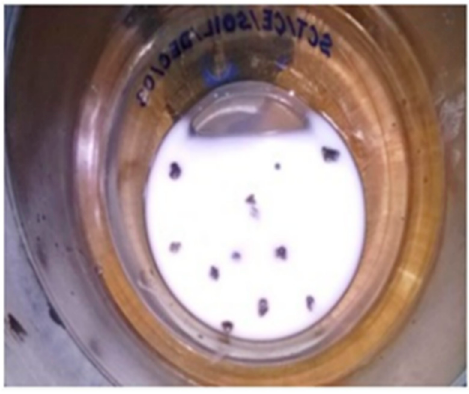
Figure 4. Lightweight particles floating in the zinc chloride